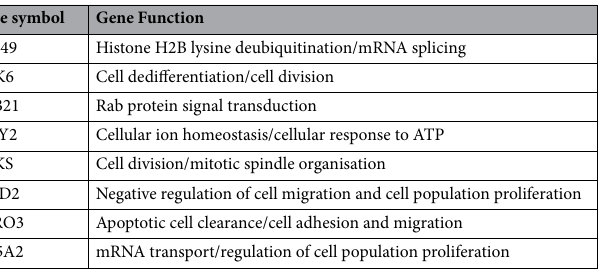
Table 6. Function of hsa-miR-140-3p and hsa-miR-30b targets involved in cancer pathophysiology. Source: https:// ensem bl. org/ and https:// unipr ot.